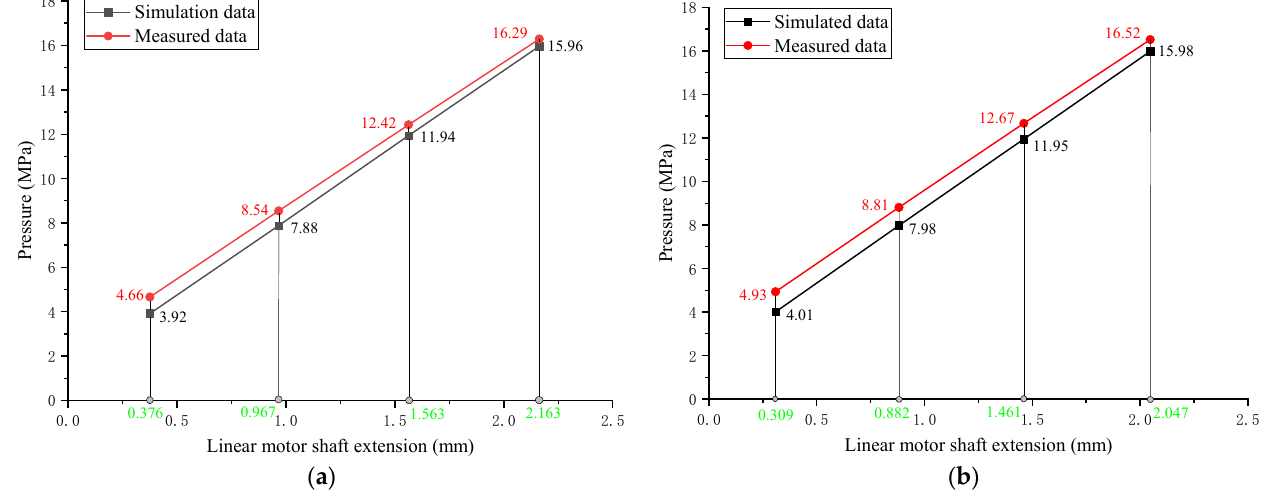
Figure 12. Pressure curves under simulated and actual working conditions: ( a ) Emulsion pump with theoretical flow of 650 L/min; ( b ) Emulsion pump with theoretical flow of 1070 L/min.